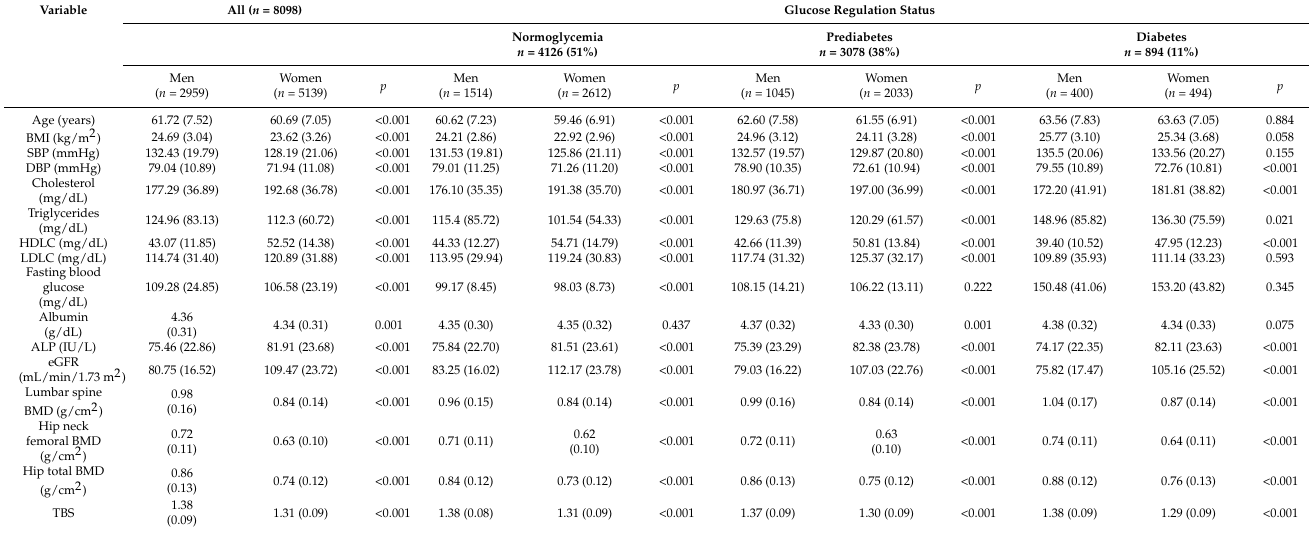
Table 1. The demographic and clinical characteristics of the individuals ( n =